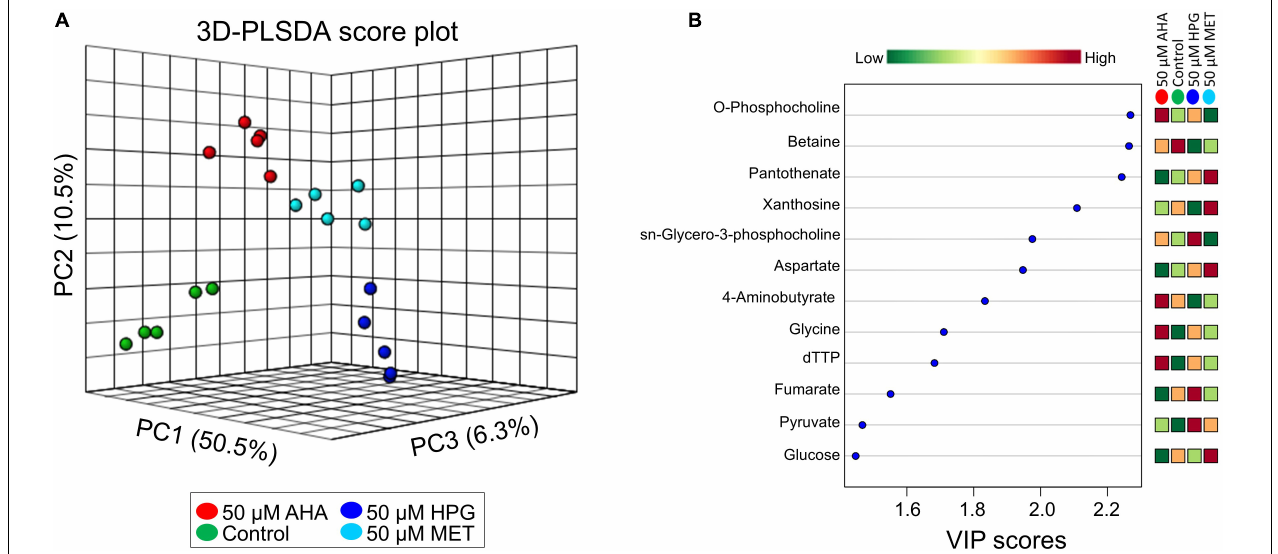
FIGURE 5 | 3D-PLSDA of metabolites as identified by NMR from the heat stressed non-canonical amino acid doped E. coli cultures and corresponding VIP scores table. (A) The PLSDA shows distinct separation between the doping groups (B) VIP shows the top 12 metabolites (out of 55 total metabolites) that contributed the most to the variation between sample type